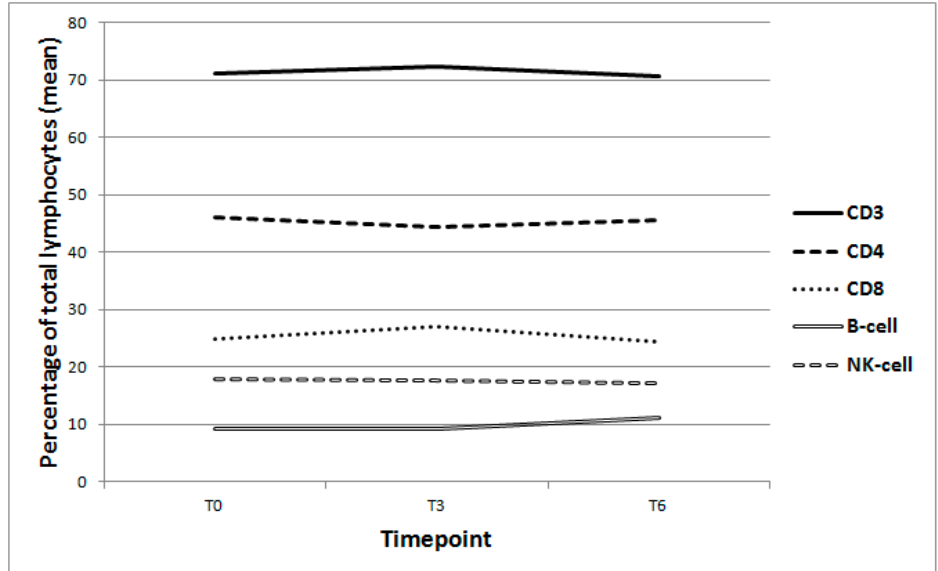
Figure A1. Comparison of mean lymphocyte subset percentages at each timepoint (T0, T3, T6) in participants for whom full data were available ( n = 9). CD3 p = 0.9131 (Friedman test). CD4 p = 0.8485; CD8 p = 0.1814; B-cell p = 0.5109; NK-cell p = 0.9466 (Repeated measures ANOVA).